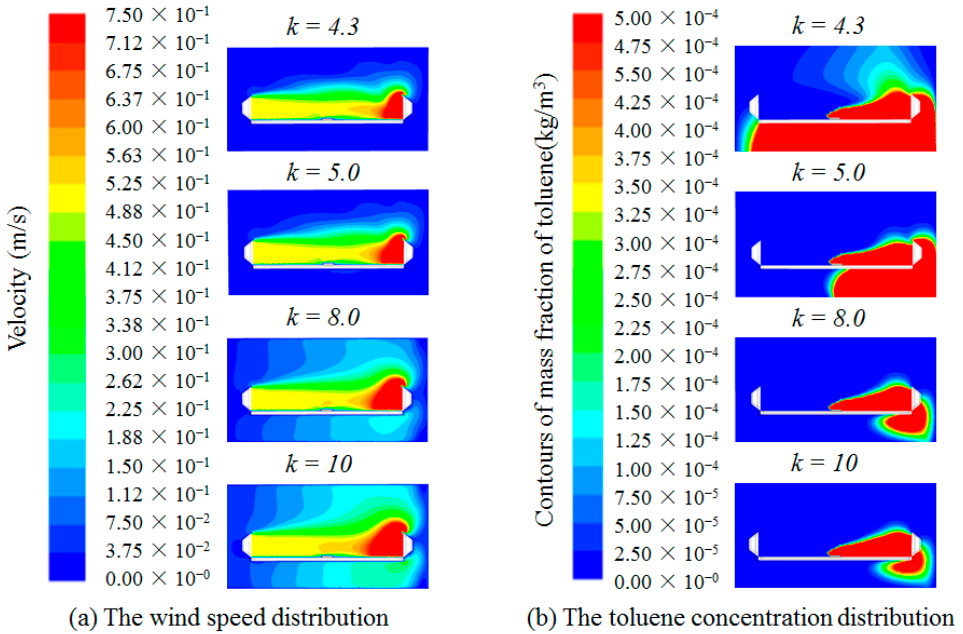
Figure 2. Distribution of wind speed and toluene concentration for different k values at L / a = 1.5.